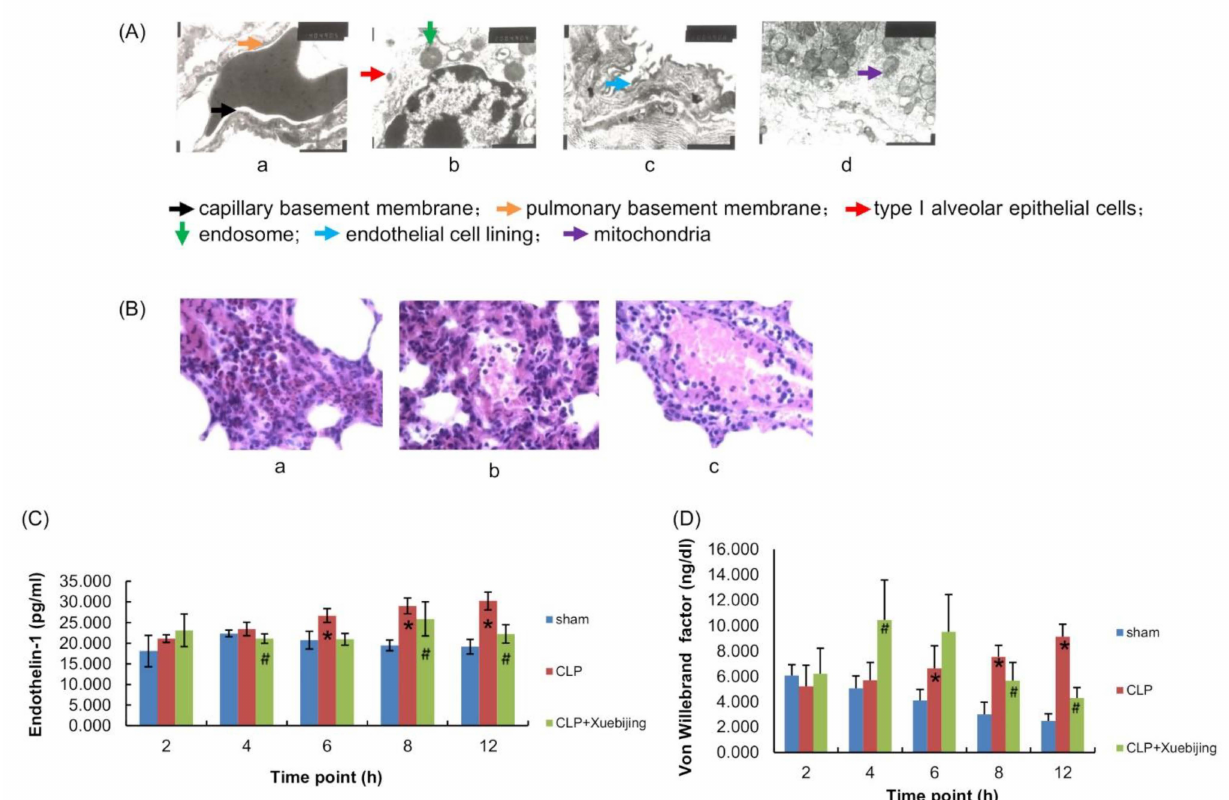
Figure 2. Xuebijing administration alleviated pulmonary endothelial injury in CLP rats. The lung tissue samples were collected from the rats in the 12 h subgroups. ( A ) Transmission microscopy was used to examine the structure of alveolar–capillary barrier. ( B ) Hematoxylin and eosin staining were conducted to examine pulmonary inflammation. ( C , D ) Blood samples were collected at 2, 4, 6, 8, and 12 h after surgery from each subgroup. The plasma levels of endothelin-1 and von Willebrand factor were measured. Data are expressed as the mean ± SD. * p < 0.05 vs. sham group; # p < 0.05 vs. CLP group; n = 5. CLP, cecal ligation and